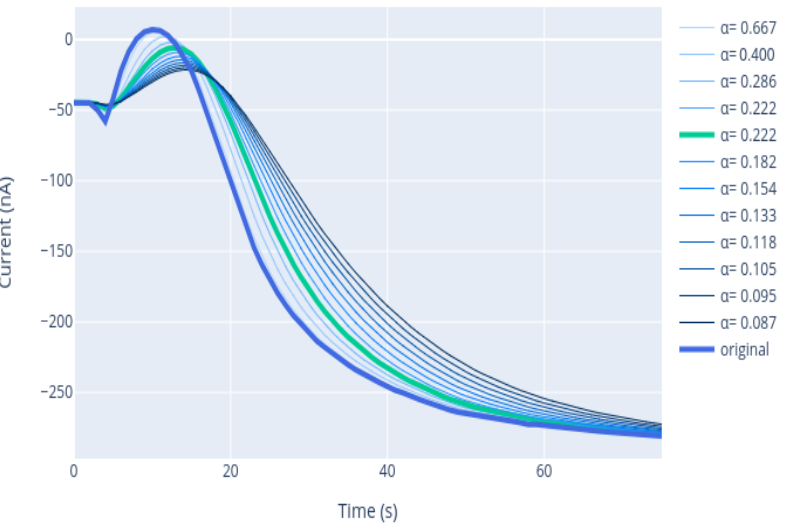
Figure 12. Finding the optimal parameter for filtering considering the influence of the filtering parameter on the original